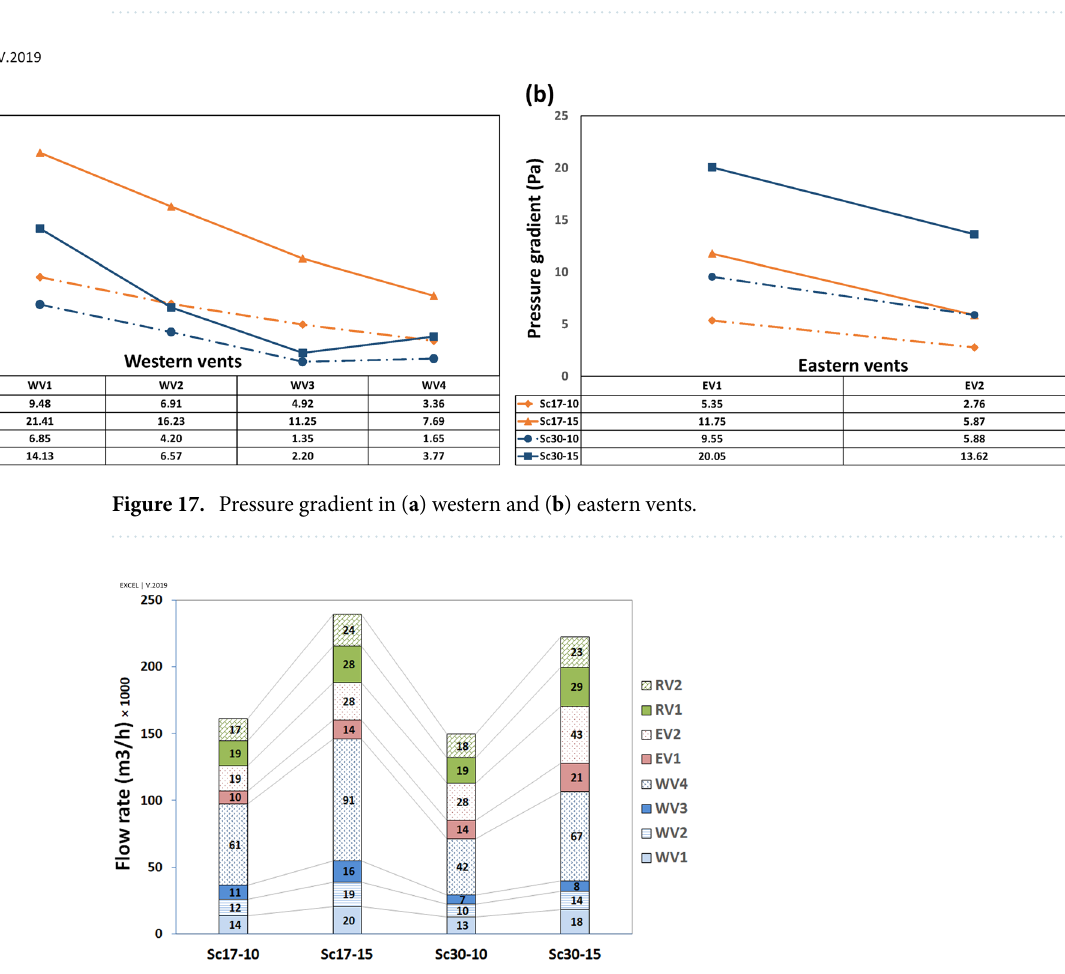
Figure 16. V y ′ of flow near the ( a ) western and ( b ) eastern vents.